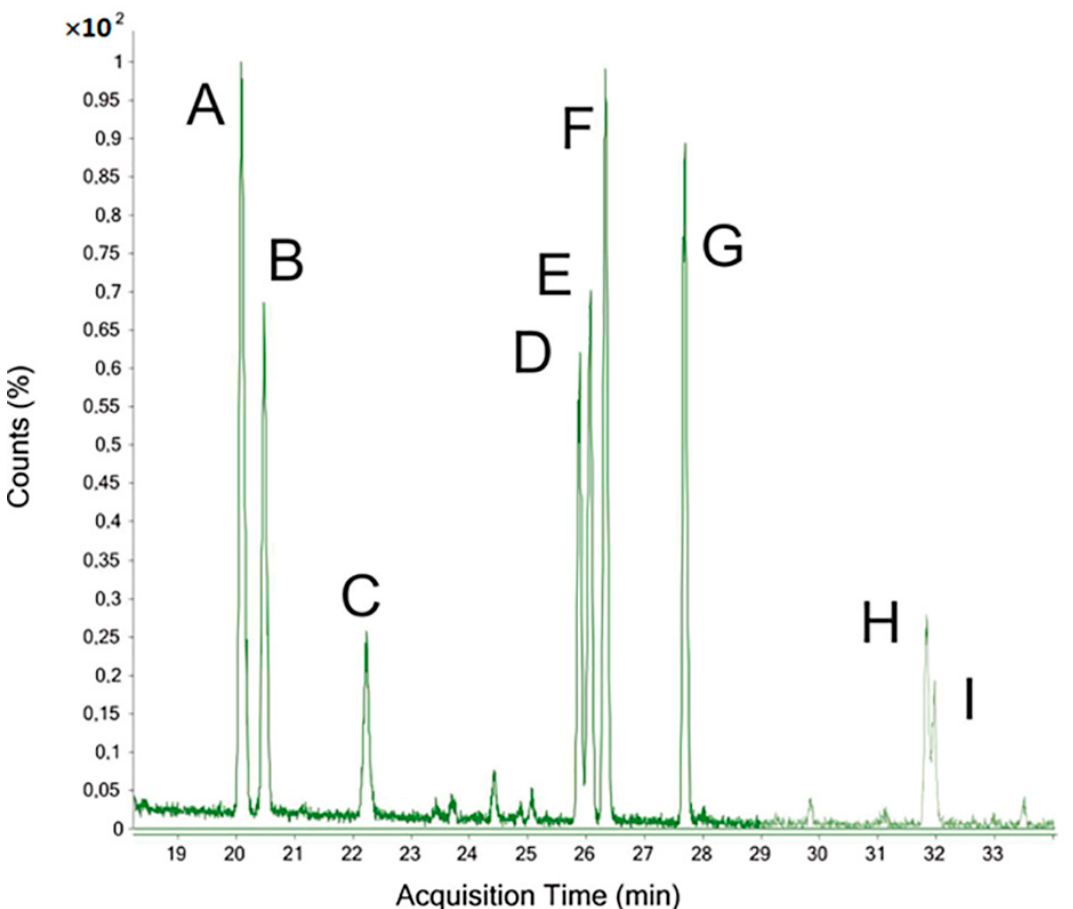
Figure 3. TIC chromatogram of PMAA derivatives obtained for the sample